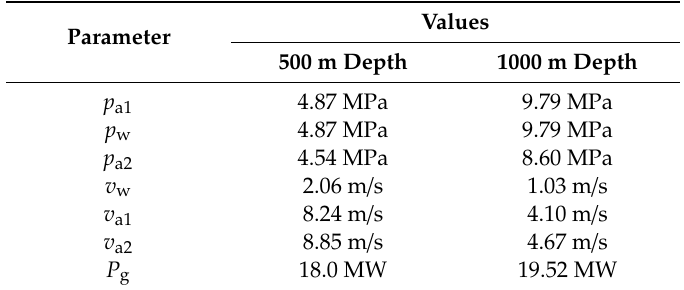
Table 2. Results for a CAES system in a roadway with di ff erent